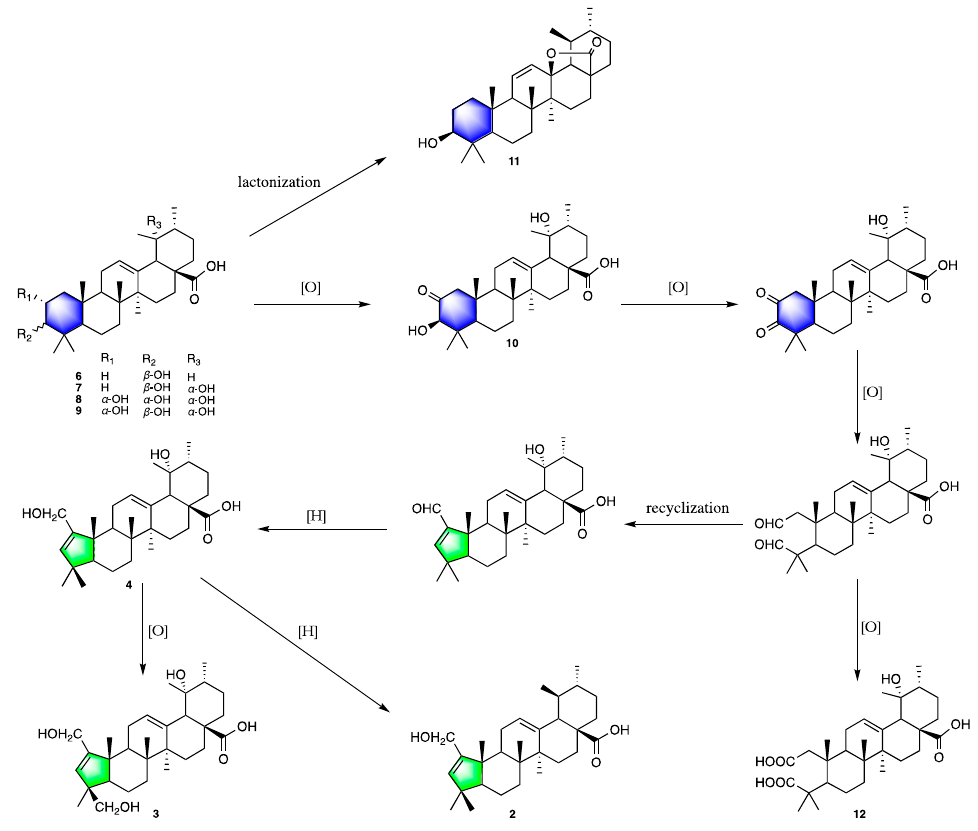
Figure 8. Plausible biosynthetic pathway for 2 – 4 and 6 – 12